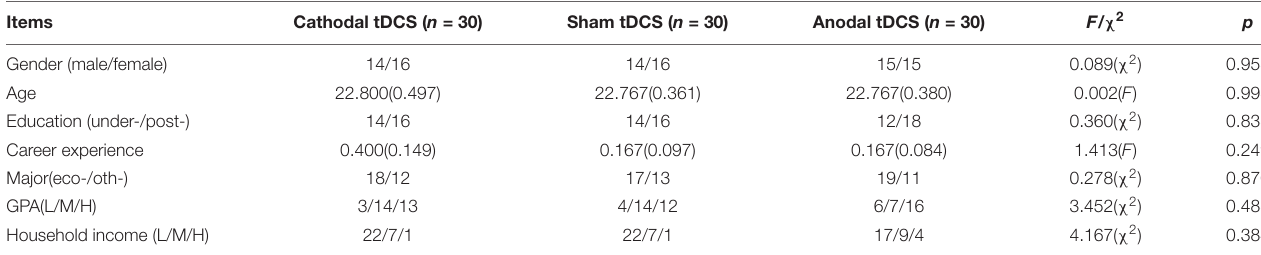
TABLE 1 | Demographic characteristics of the three